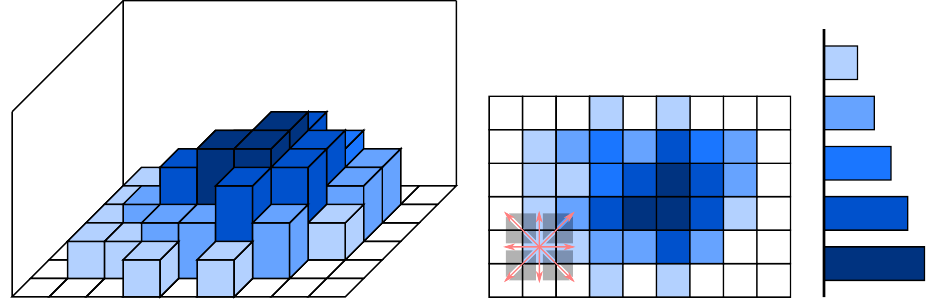
Figure 6. The maximum values in the grid form the basis for an elevation profile in which the eight neighborhood is analyzed for each cell, and eight corresponding gradients are calculated. The set of all these gradients must fall within the specified